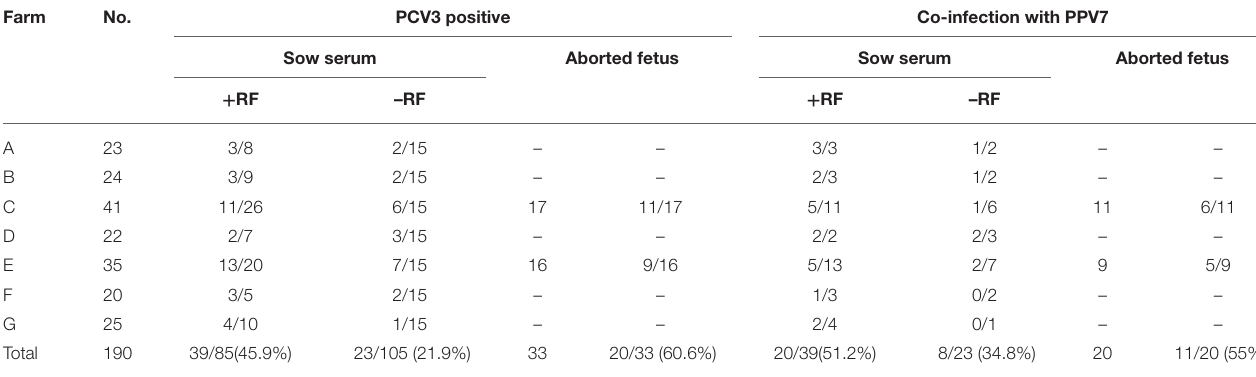
TABLE 2 | Presence of PCV3 and PPV7 co-infections in serum of sows, with and without reproductive failure (RF), and in aborted fetuses. Farm No.